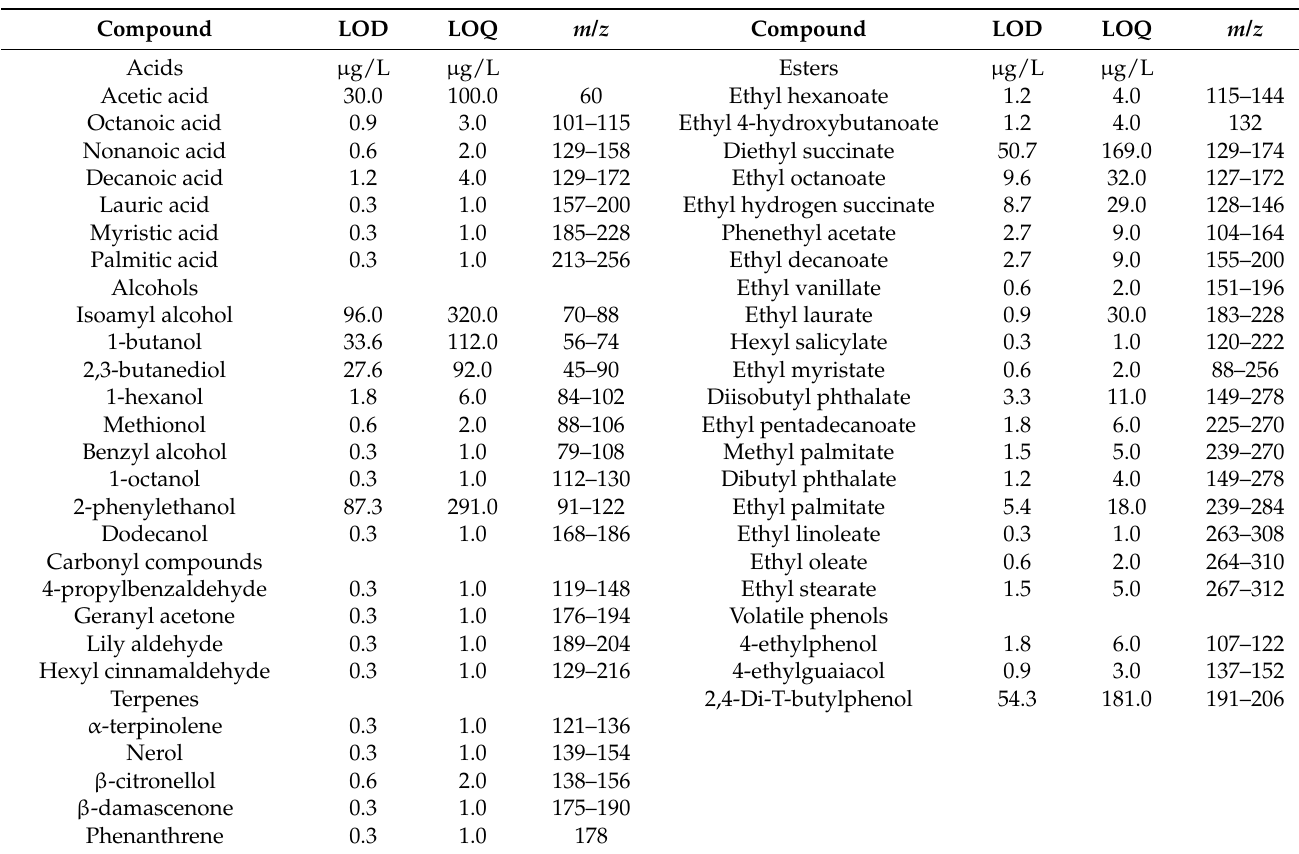
Table 7. The limit of detection (LOD), limit of quantitation (LOQ) and mass to charge ratio ( m / z ) of volatile compounds identified in Cabernet Sauvignon wine, RO and NF retentates.